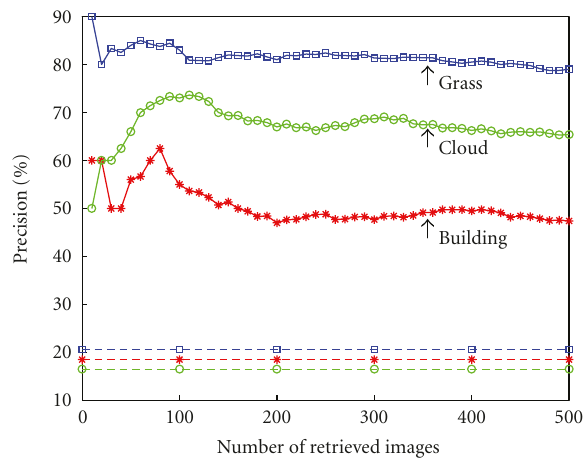
Figure 13: The retrieval precisions curves for 3 concepts compared with the average percentages.